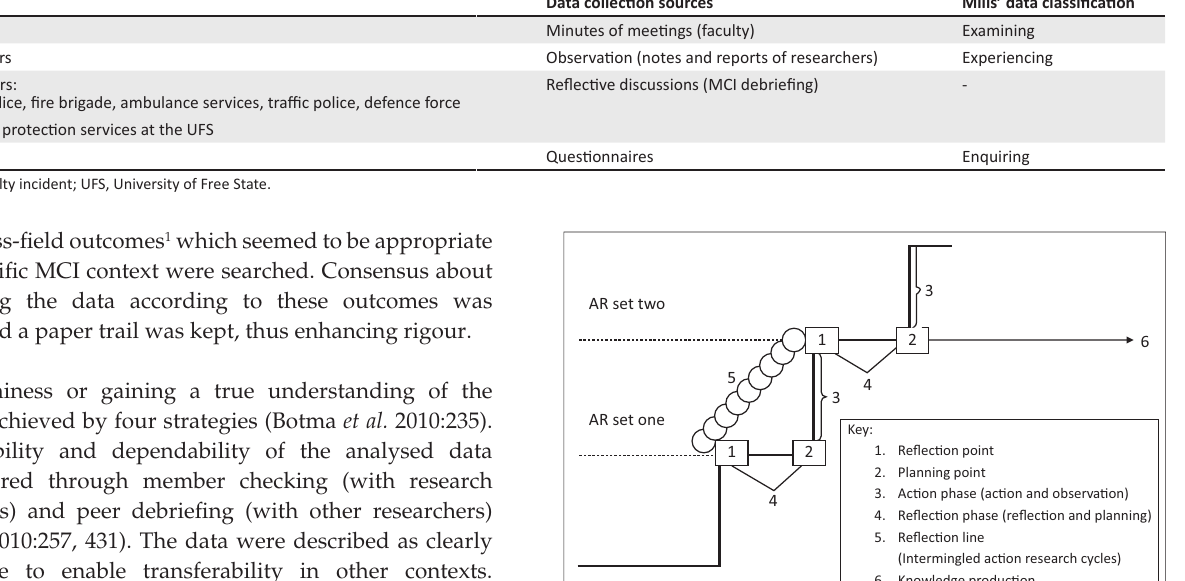
TABLE 1: Data collection methods used, classified according to Mills’ taxonomy.